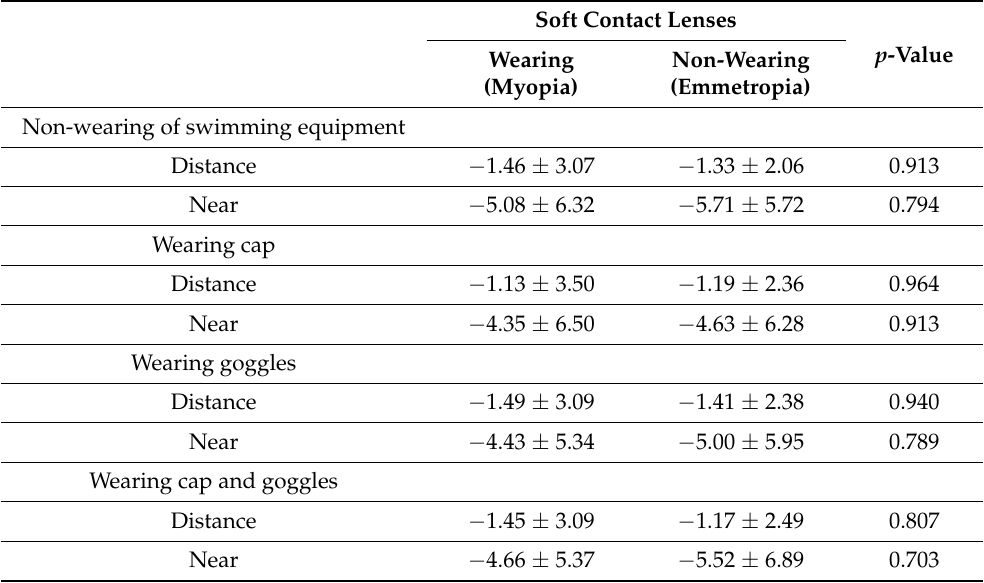
Table 2. Differences in phoria between wearing (myopia) and non-wearing of soft contact lenses